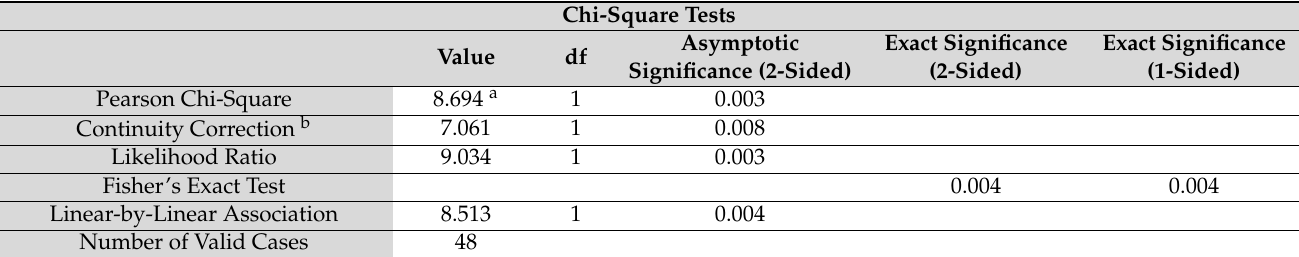
Table 2. Results of the chi-square test of independence showing that SC patients were significantly more likely than nSC patients to have neuropsychiatric